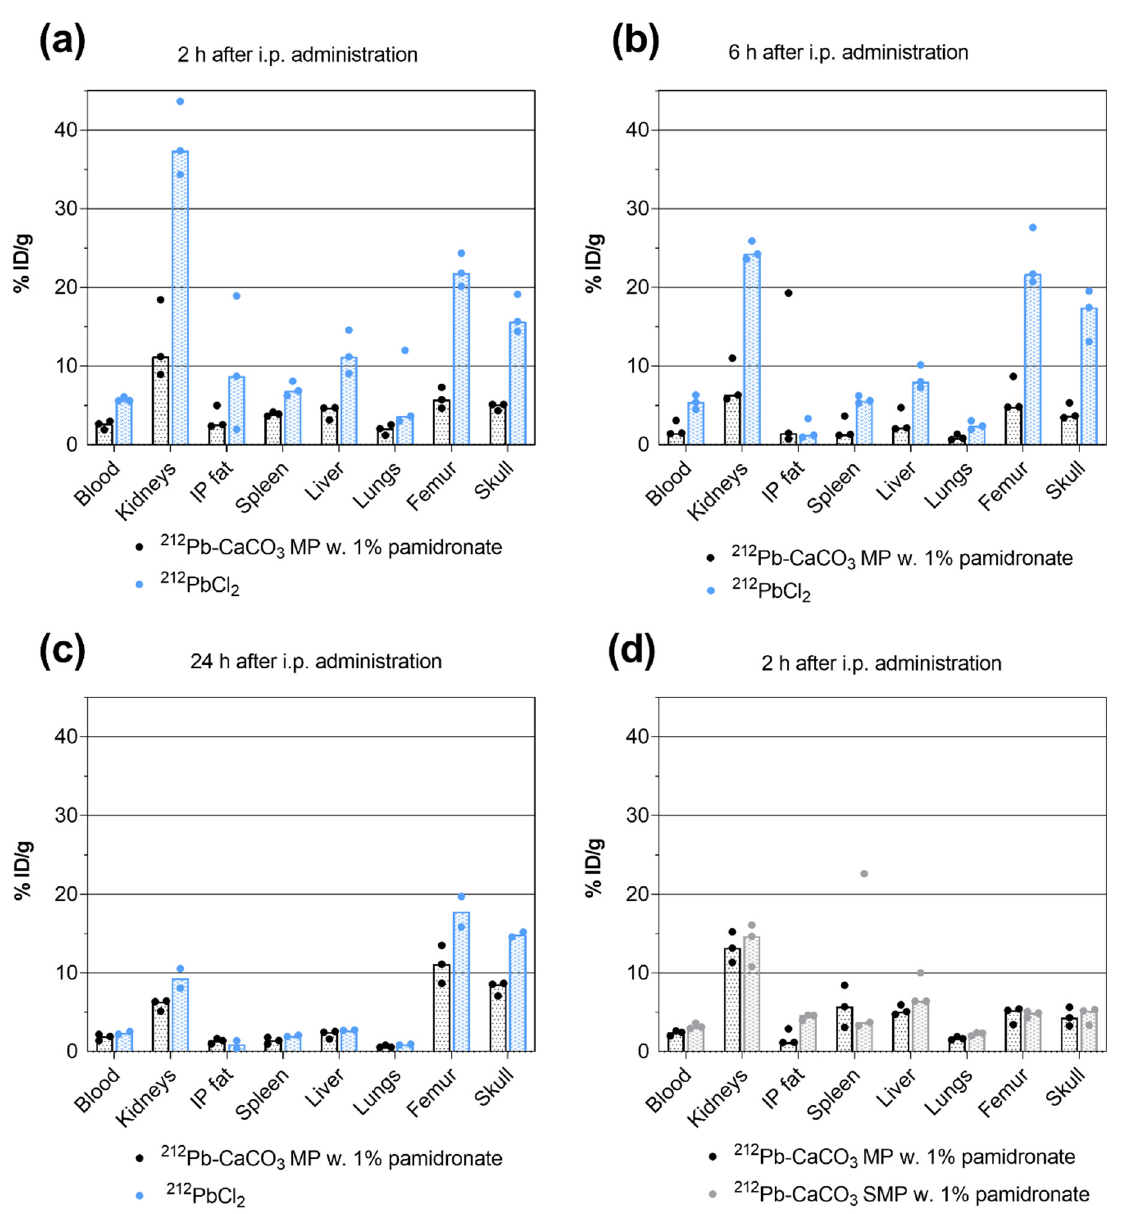
Figure 6. Biodistribution of 212 Pb evaluated as the percentage of injected dose per gram (% ID/g) of tissue at a designated time following intraperitoneal (i.p.) administration. The bars represent the medians, and the symbols represent individual animals. ( a – c ) 212 Pb-CaCO 3 MPs compared with unbound 212 Pb 2+ administered as 212 PbCl 2 , in terms of % ID/g of tissue after ( a ) 2 h, ( b ) 6 h, and ( c ) 24 h. ( d ) Data from the study comparing the biodistribution of 212 Pb-CaCO 3 MPs to that of SMPs produced in the presence of glycerol.